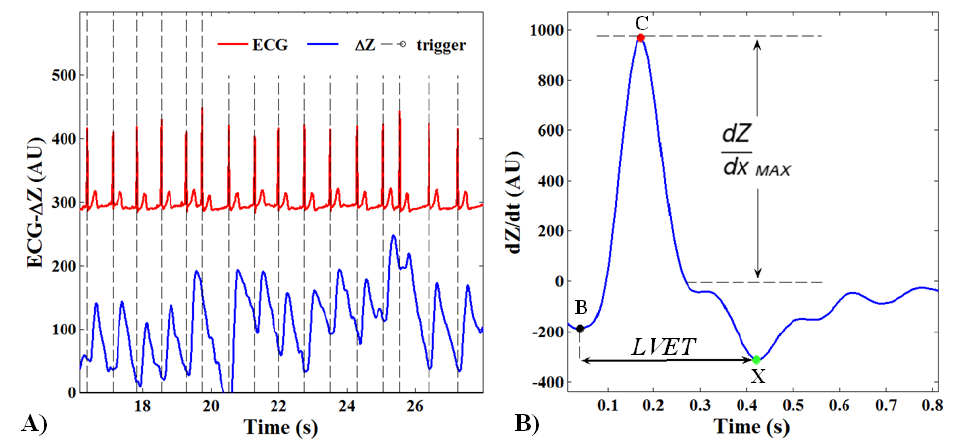
Figure 3. Example of the ICG processing workflow. ( A ) The Δ Z signal is shown with its respiratory component, the identified R peaks of the ECG signal trigger the subsampling on Δ Z ; ( B ) the interesting points B-C-X automatically recognized on the averaged Δ Z are